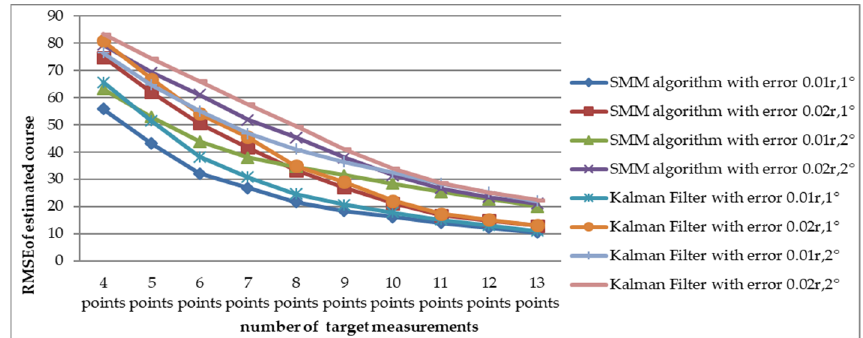
Figure 10. Comparison of estimated course RMSE between SMM algorithm and adaptive Kalman filter versus different detection error (Scenario 7).